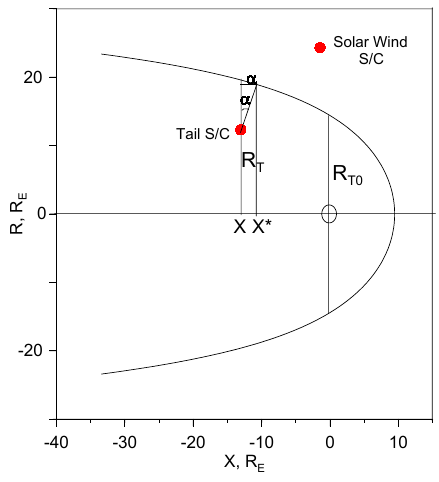
Figure 1. The scheme, illustrating the procedure of R T calculation. radius value at terminator (at x = 0). As in PR96, the α(x) dependence is taken as sin 2 α = A 2 exp (Cx) . According to the statistical study by Shukhtina et al. (2004), the average C value is C = 0 . 0714. All formulas are presented in the geo- centric solar magnetospheric (GSM) coordinate